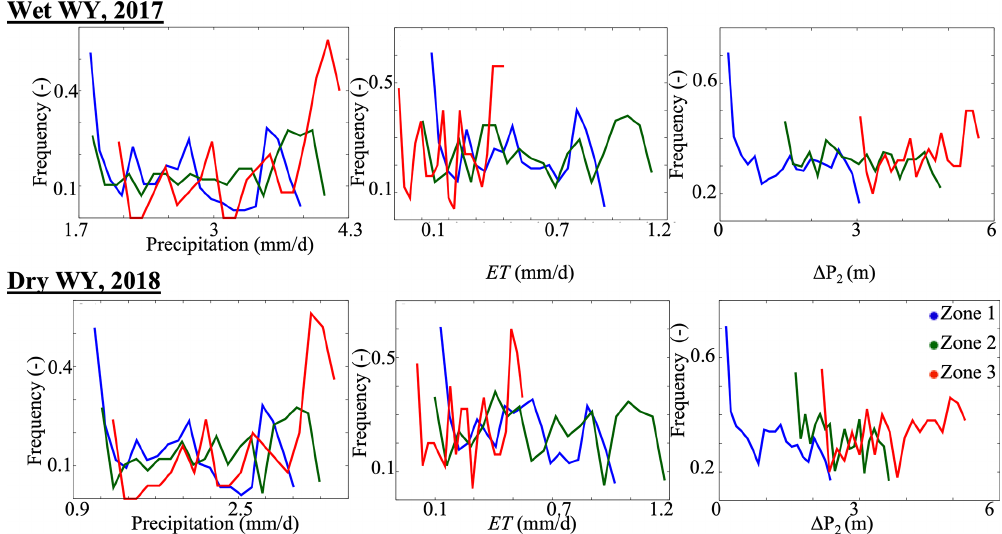
Figure 10. Frequency distributions of hillslope annual average daily rates of precipitation and evapotranspiration (ET), and the hillslope seasonal changes in groundwater levels ( (cid:49)P 2 ), in 2017 (wet WY) and 2018 (dry WY) of the three zones derived from the WY 2015 (cid:49)P 1 .